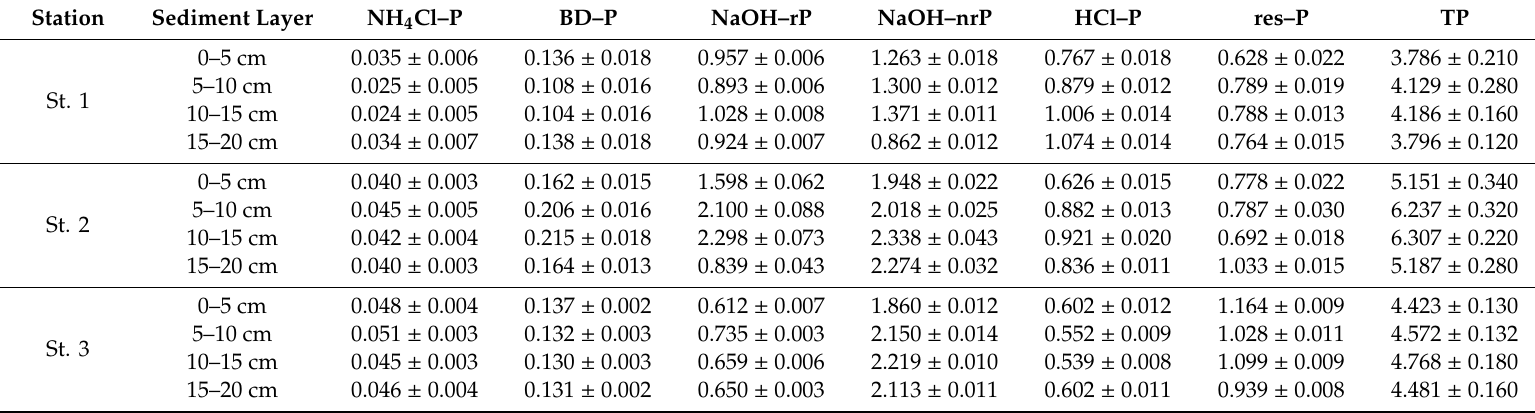
Table 5. The mean ( ± SD) values of phosphorus fractions and total phosphorus in Długie Lake sediment (in mg g − 1